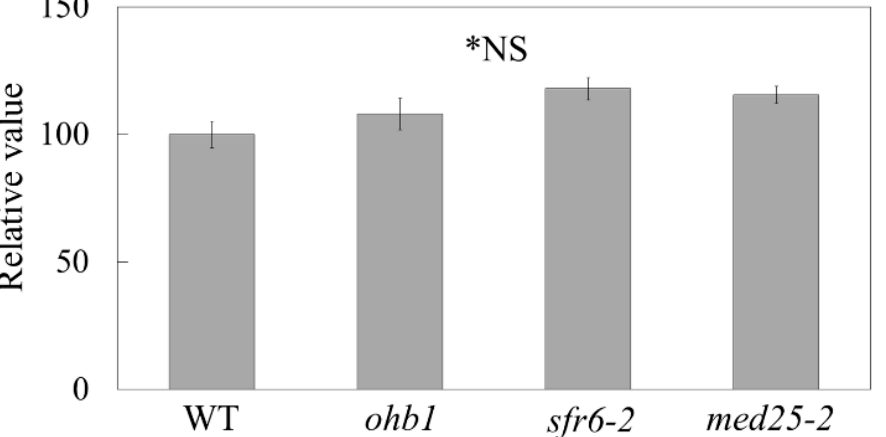
Each value is expressed as the mean ± SE relative to the respective WT value, which was set at 100. Different letters in each column represent significant differences between the mutants according to Tukey’s test ( p < 0.05, n = 20 and 10 for each petal and sepal category, respectively).